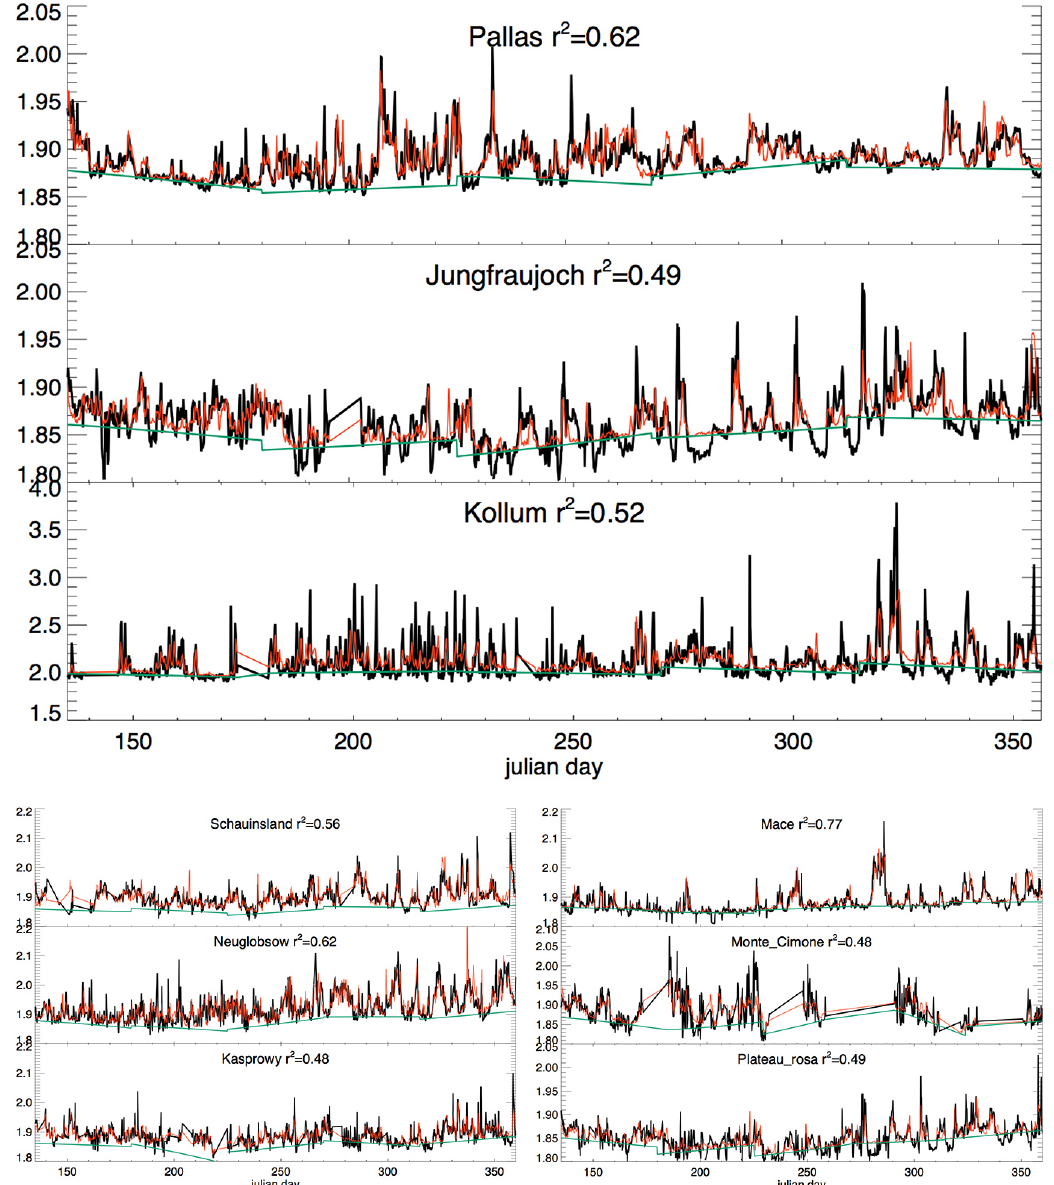
Fig. 4. Observed (black) and analyzed (red) hourly methane concentrations (ppm) at nine European locations for the year 2010. Contribution from the retrieved background concentration is shown in green. Please note that different y -axis scales are used for the different